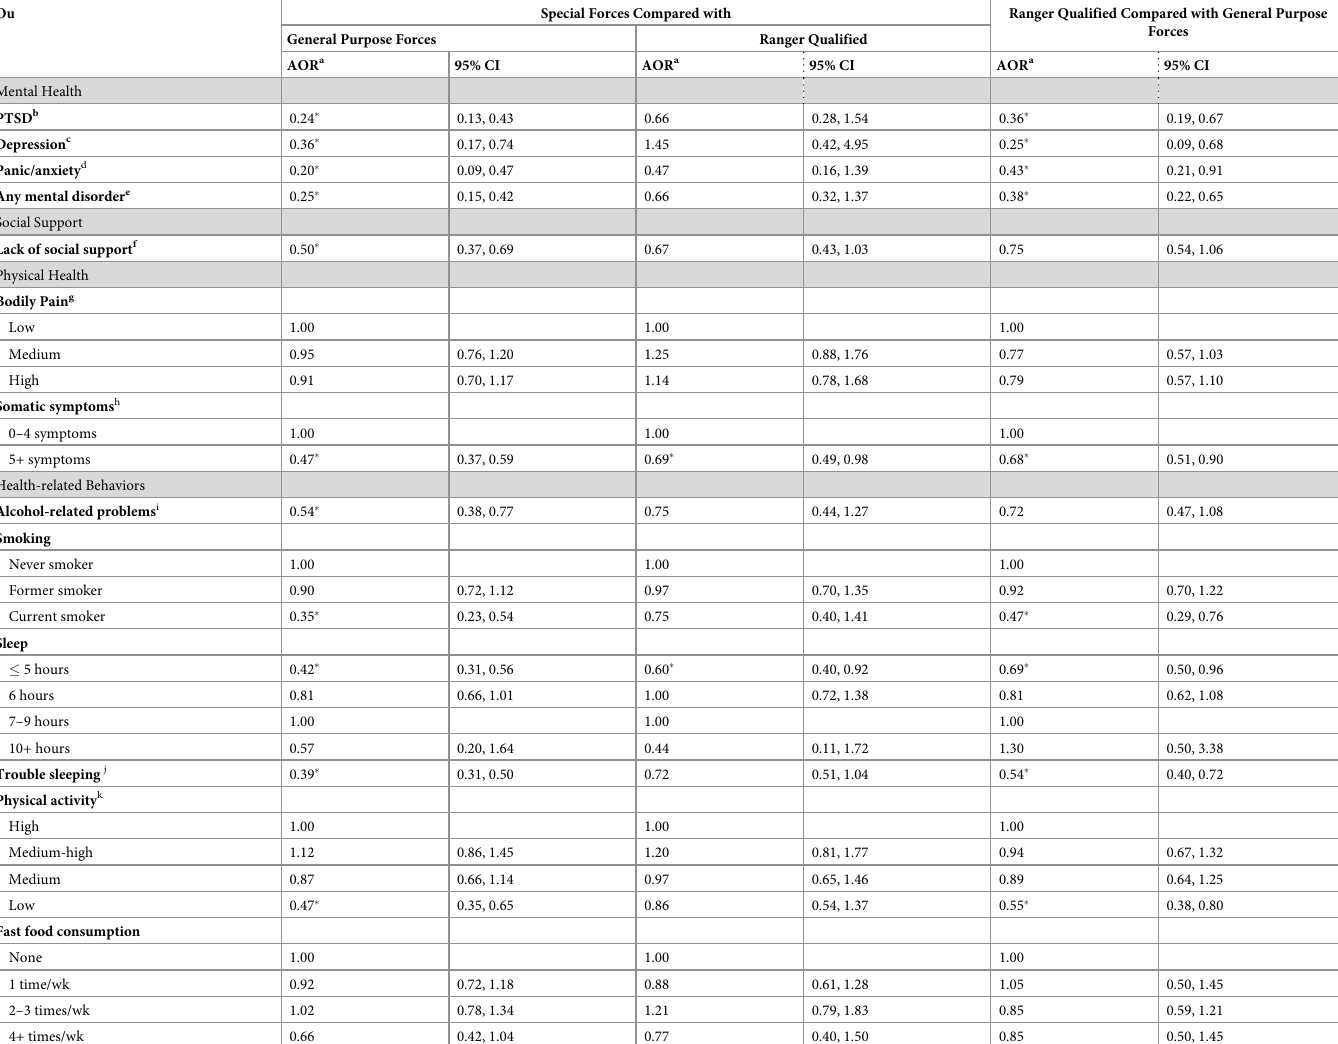
Table 3. Adjusted odds ratios of mental health, social support, physical health, and health-related behaviors outcomes by Army specialization among soldiers, the Millennium Cohort Study. Ou SpecialForcesComparedwith RangerQualifiedComparedwithGeneralPurpose